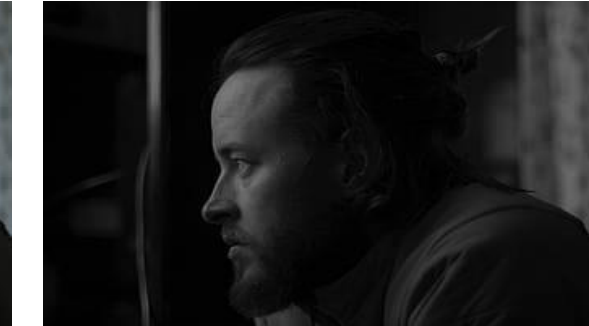
Figure 2. Non-frontal face image [86]. Figure 3. Non-frontal face image with variation in